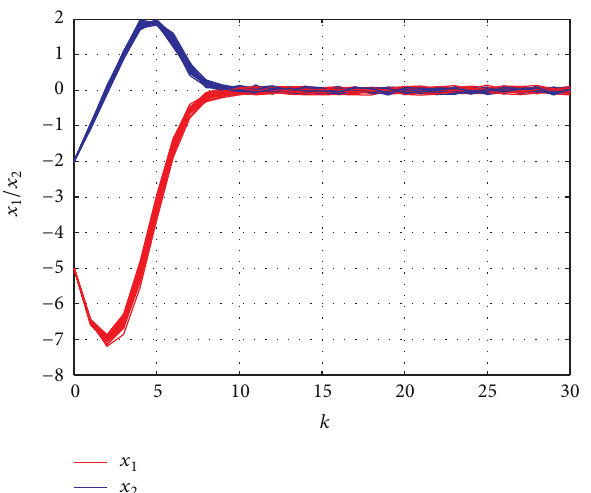
Figure 4: The state trajectories of 𝑥 1 and 𝑥 2 ( 𝑁 = 9 ).